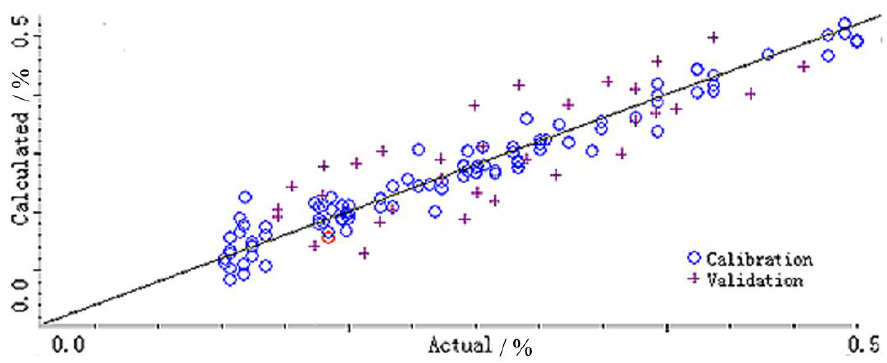
Figure 4. Correlation between predicted content and authentic content. represents calibration; + represents validation.